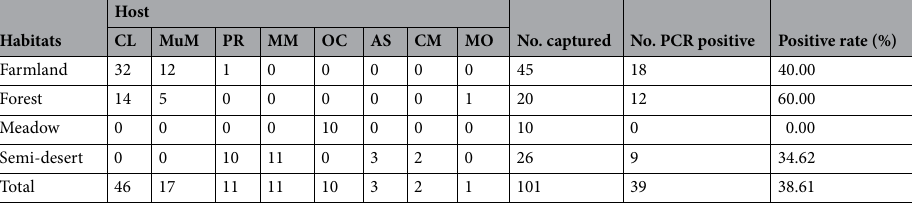
Table 2. Positive rate of Bartonella infection of small mammals in different